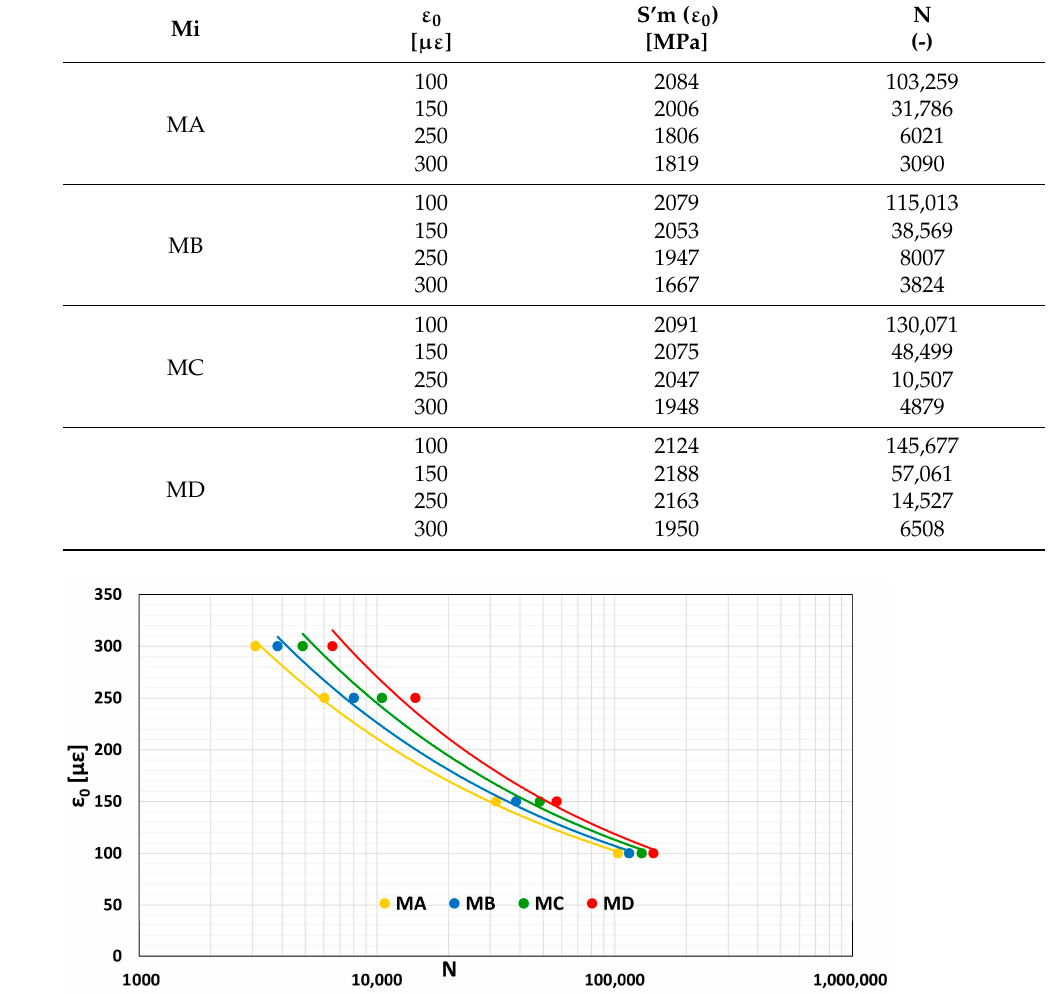
Figure 10. Mi4.25G fatigue curves. Table 3. Results of the fatigue tests.